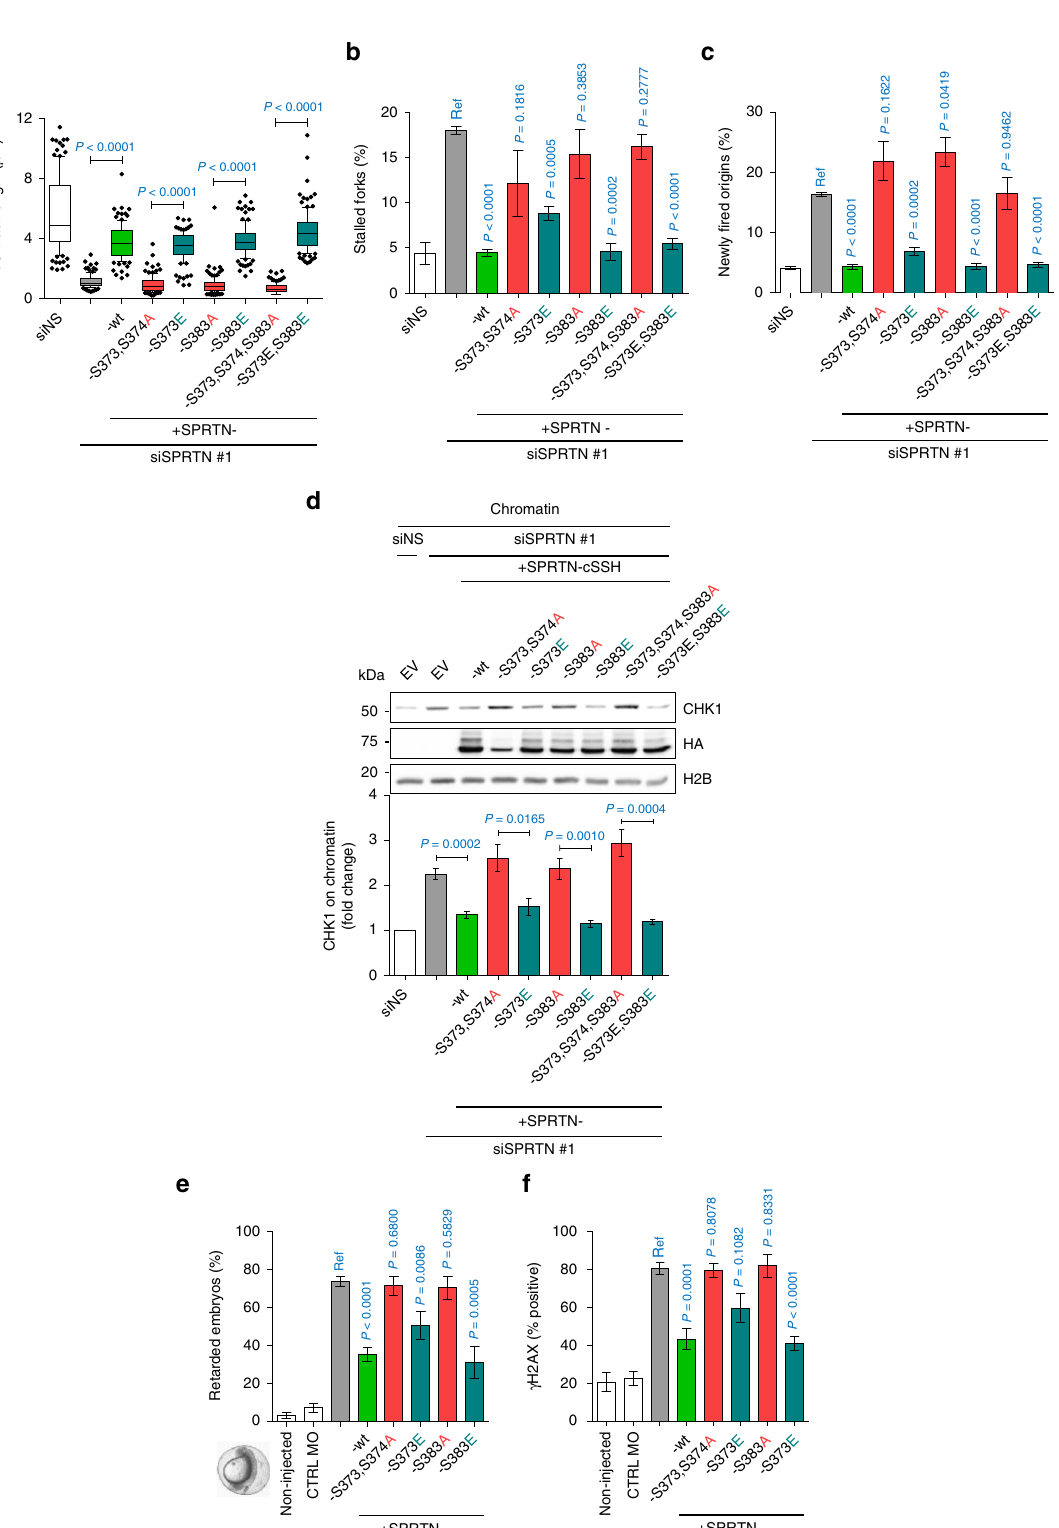
SPRTN activity 26 . However there are two arguments against this model: (i) SPRTN is an essential enzyme for DPC repair during DNA replication, yet DPCs prevent the helicase – polymerase uncoupling and the ssDNA formation that would be required to activate SPRTN, and (ii) SPRTN protease activity towards DNA- binding substrates is also stimulated by dsDNA 25,27 ,